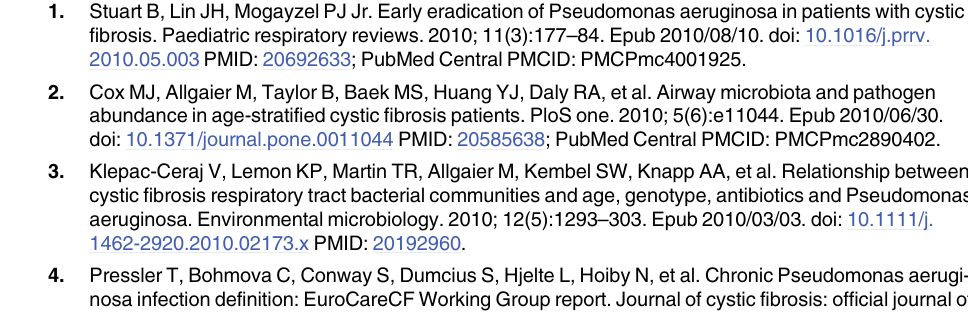
S1 Table. Characteristics of